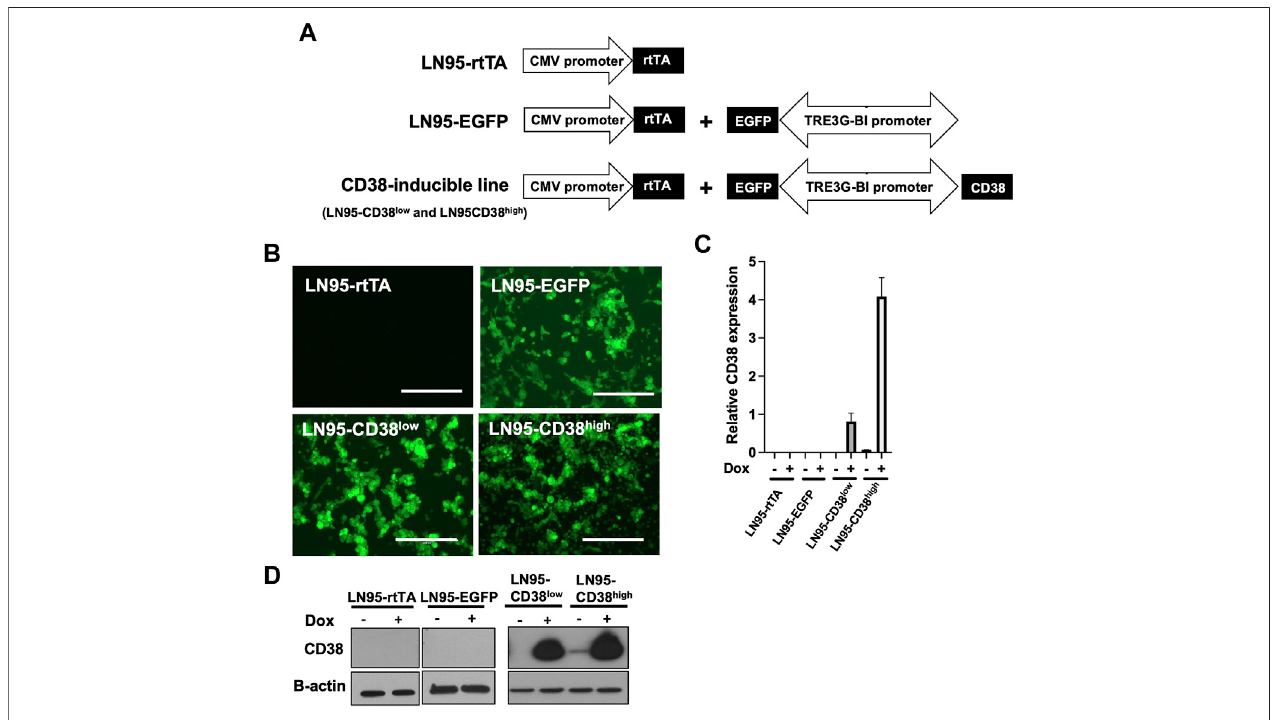
FIGURE 1 | Generation of CD38-inducible stable lines. (A) A schematic presentation of CD38-inducible stable lines and controls. (B) EGFP emission observed by fl uorescence microscope following 100 ng/ml Dox for 48 h. Scale bars: 400 μ m. (C) CD38 expression level determined by qRT-PCR following 100 ng/ml Dox for 48 h. Mean ± SD values from four replicates are shown. (D) CD38 induction con fi rmed by Western blot analysis after 48-h incubation with or without 100 ng/ml